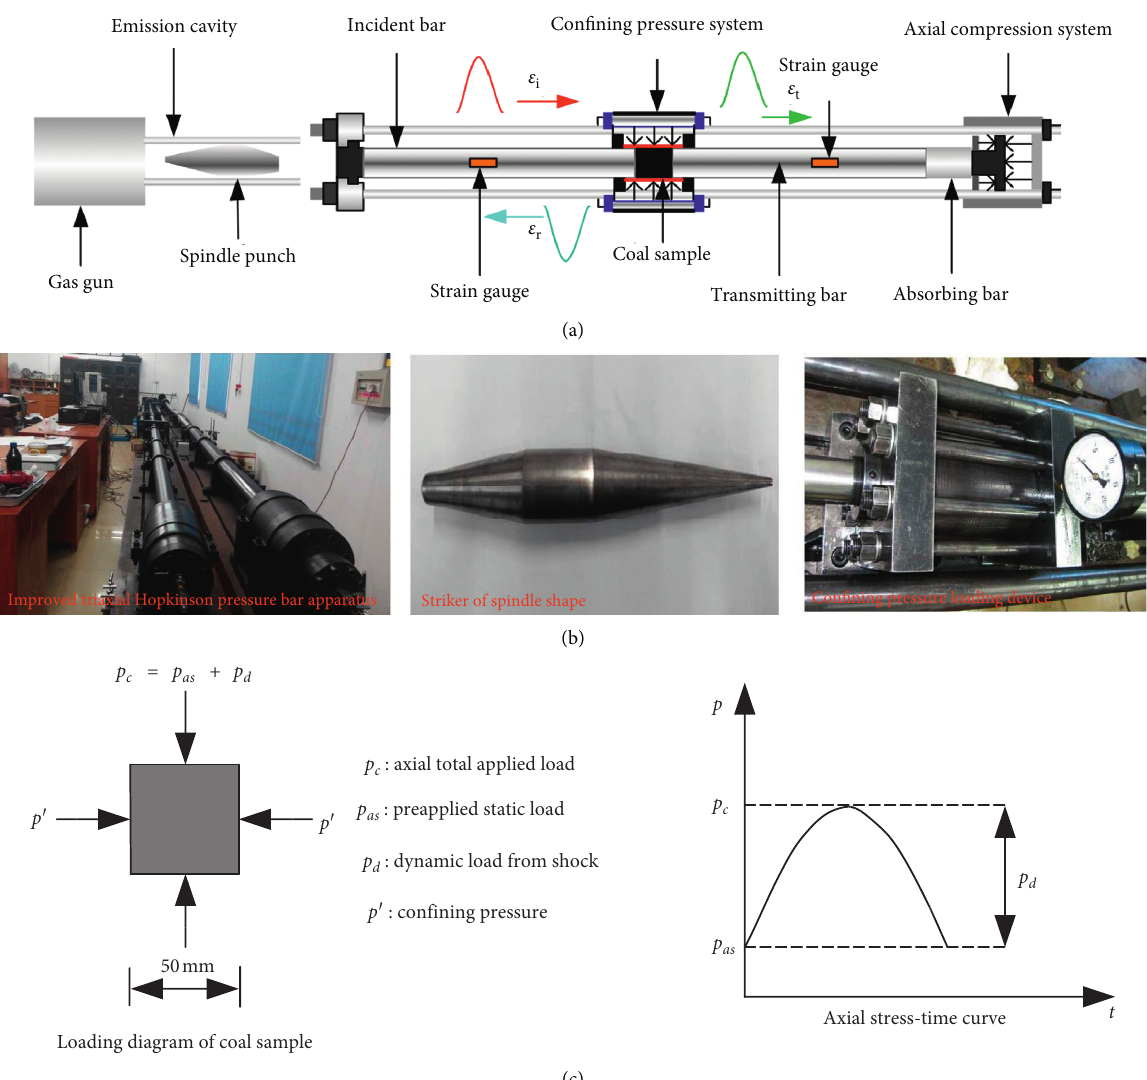
Figure 3: Experimental equipment and specimen loading mode: (a) schematic diagram of the improved Hopkinson pressure bar apparatus, (b) photographs of SHPB, and (c) schematic diagram of the composition of the load applied to the